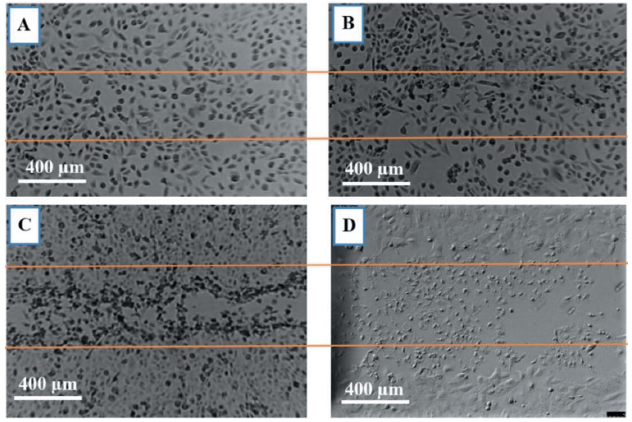
Figure 8 Human lung cancer A549 monolayer cells 24 h after being exposed to SBB with field size of 500 m m. The radiation fields are marked between orange lines: (A) 50 Gy, (B) 100 Gy, (C) 500 Gy and (D) 1000